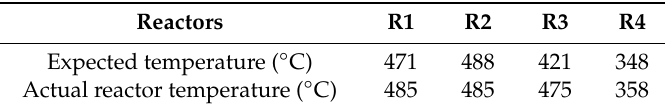
Table 1. Expected and actual reactor